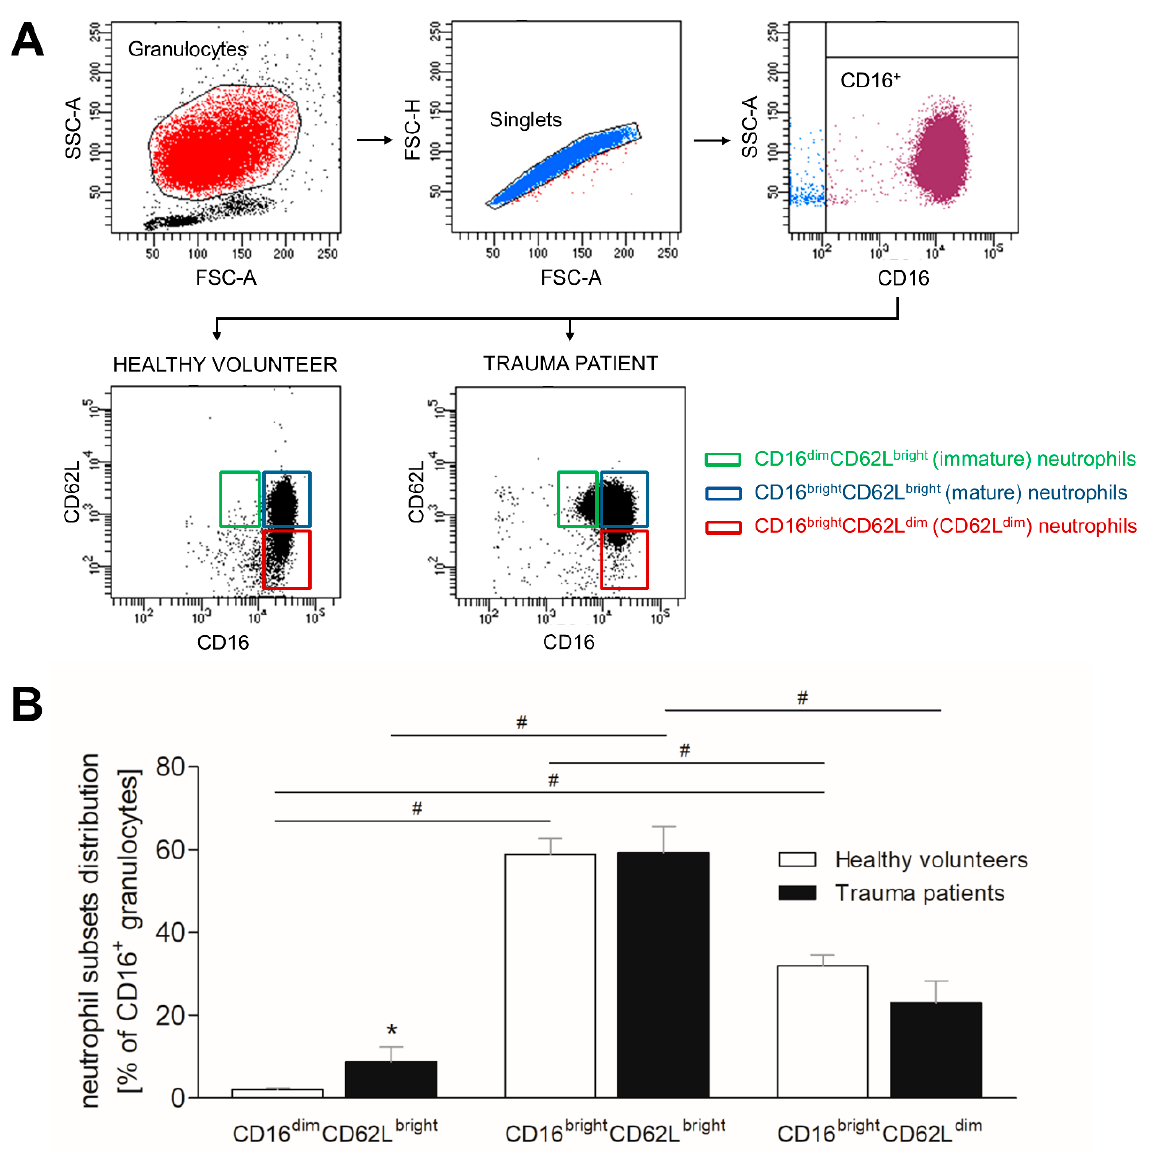
Figure 1. Impact of severe traumatic injury on neutrophil subset distribution. ( A ) Representative gating strategy for phenotyping human neutrophil subsets, including size discrimination, doublet exclusion, selection of CD16 + cells, and separation according to expression of CD16 and CD62L. ( B ) The percentage distribution of CD16 dim CD62L bright (immature), CD16 bright CD62L bright (mature) and CD16 bright CD62L dim (CD62L dim ) neutrophils out of CD16 + granulocytes was determined in healthy subjects (white bars) and severely injured patients (black bars) within 12 h postinjury. Data are presented as mean ± standard error of the mean. *: p < 0.05 vs. healthy volunteers; #: p < 0.05 vs. respective subset.